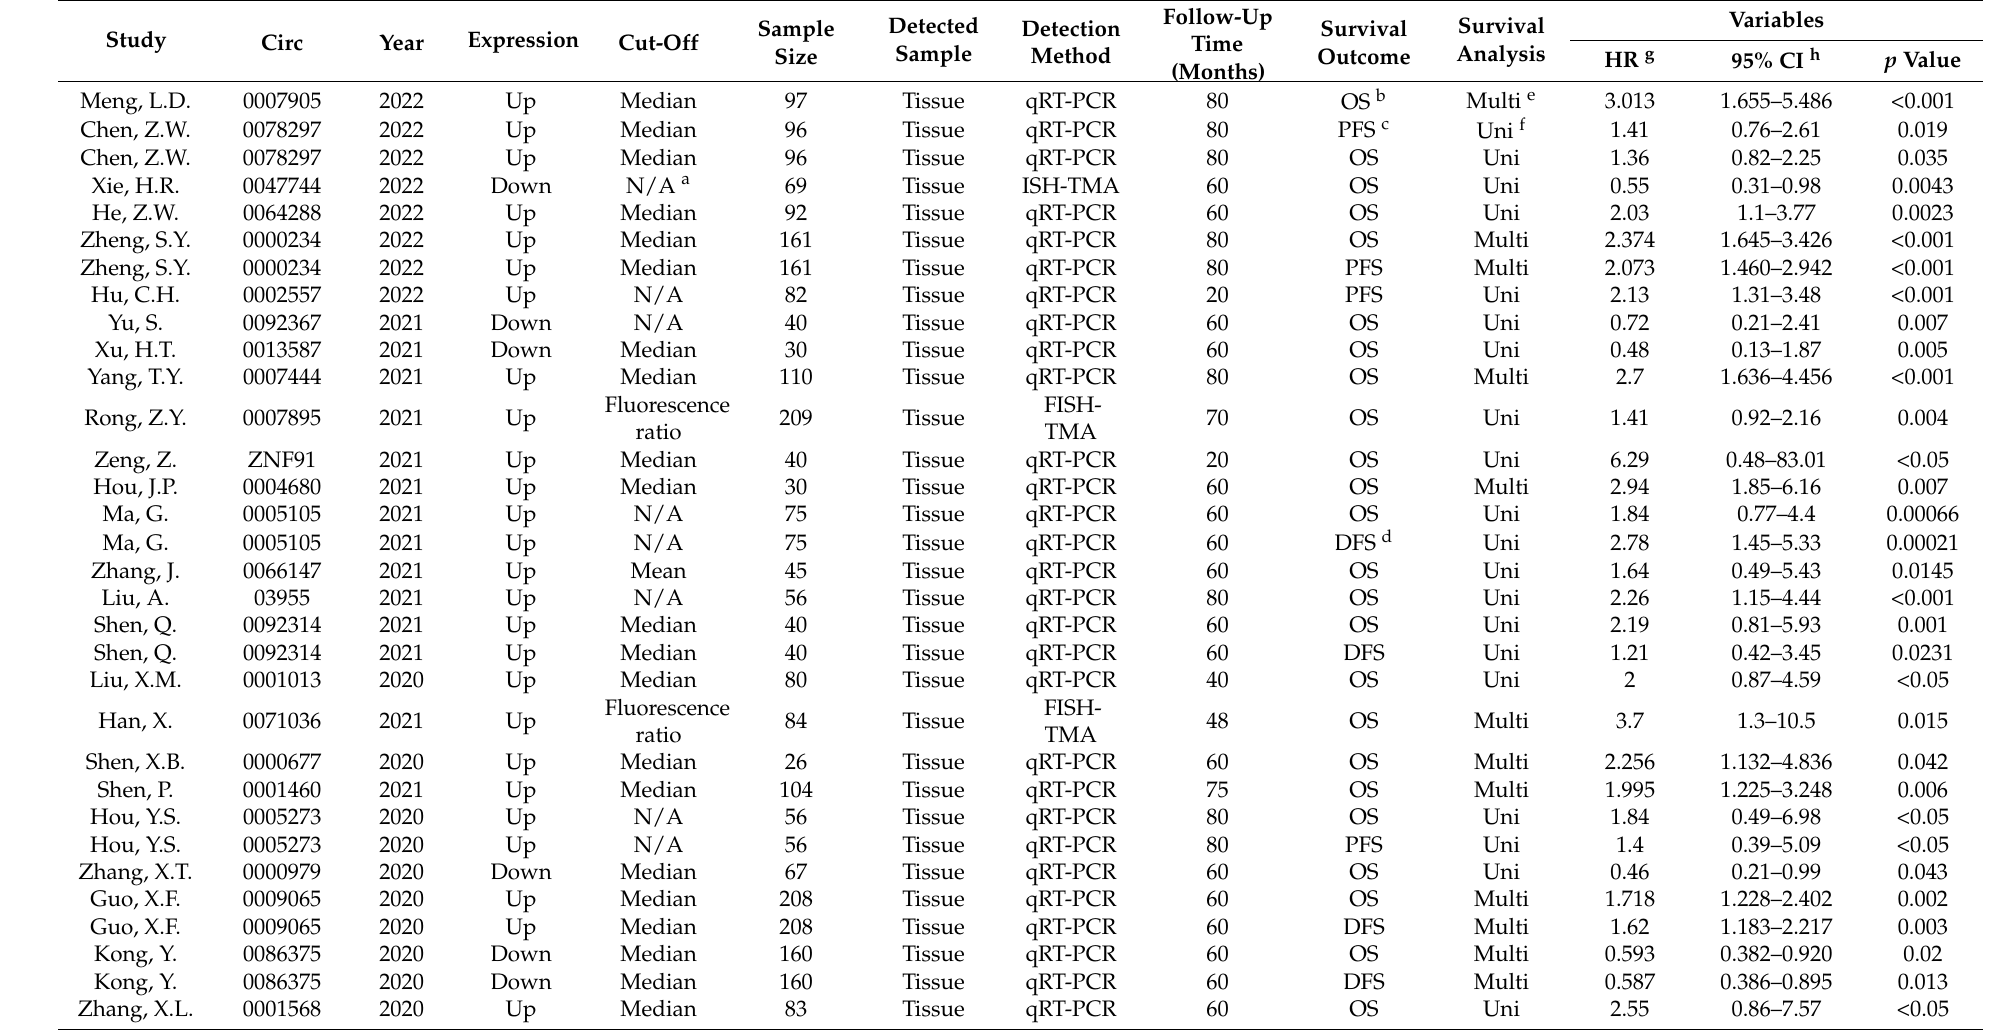
Table 1. Characteristics of prognostic studies included in the